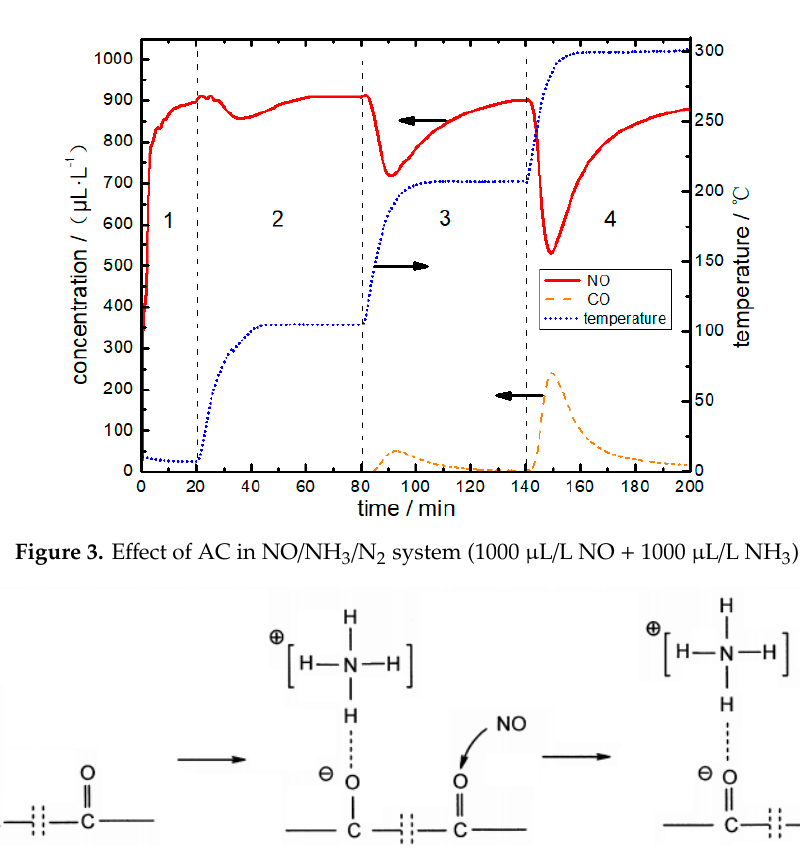
Figure 4. Reaction mechanism of NO reduction with NH 3 on the AC surface.